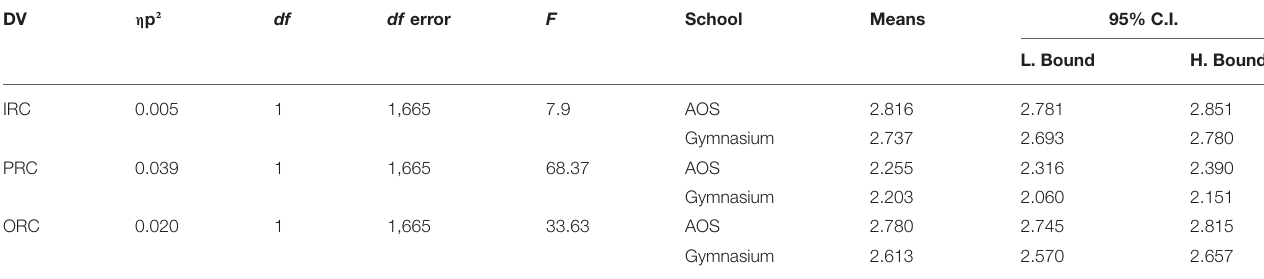
TABLE 4 | Significant univariate effects for school type (all significant at p < 0.01). DV η p ² df df error F School Means 95% C.I.